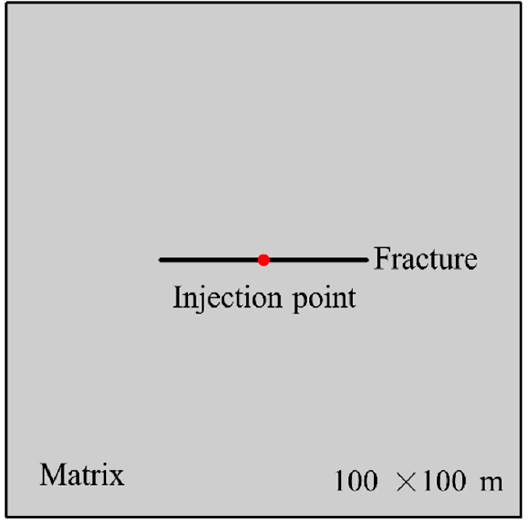
Figure 7. Geometric model for the comparison between UXFEM and COMSOL.